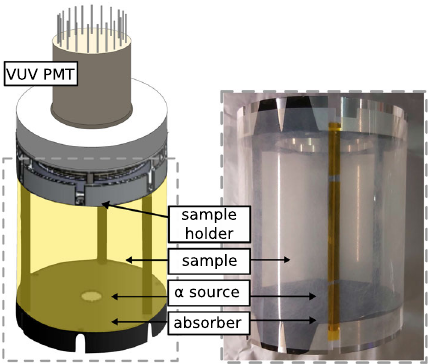
Fig. 9 Left: schematic of the sample cell. Right: picture of the sample holder covered with the absorber (described in Sect. 2) and surrounded by sanded PEN, which is shown before attaching TTX to it. Kapton tape is used to close its volume from outside (behind the support rod). The PMT limits the sample cell on the top